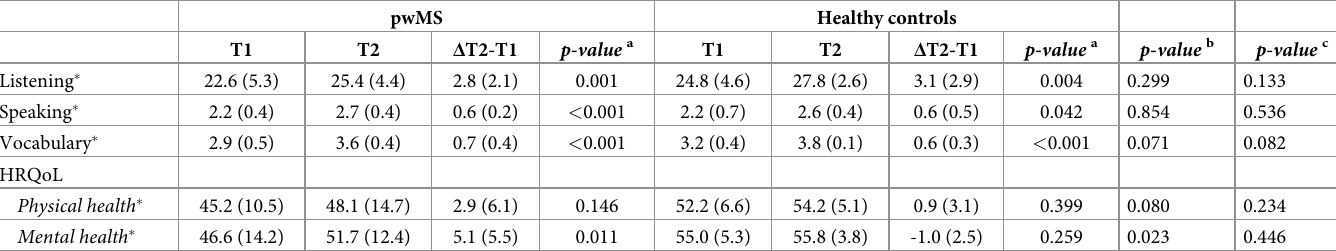
Table 3. Assessments of second language learning proficiency and health related quality of